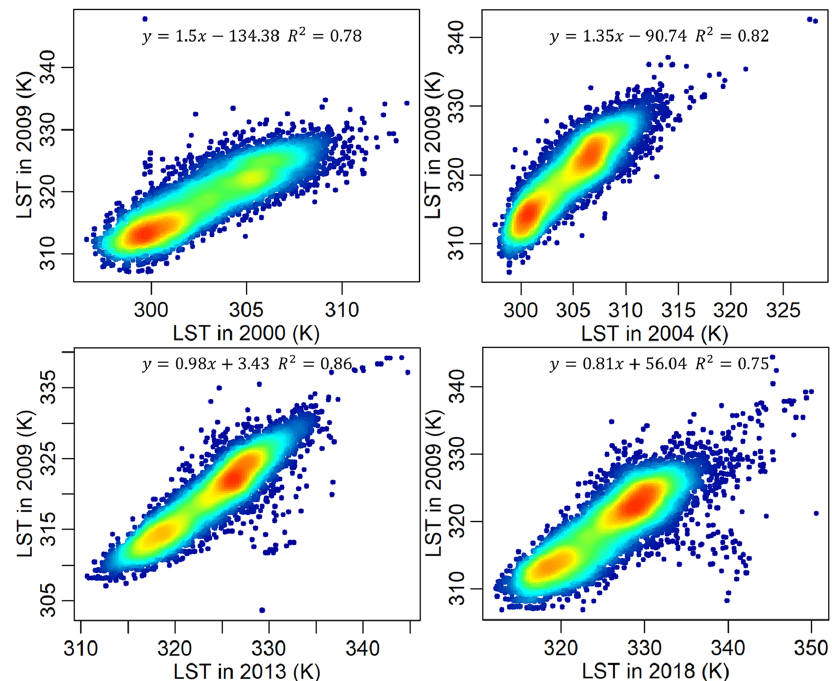
Figure 7. Scatterplot for LST of the PIFs between the target image (X-axis) and the reference image (Y-axis), the color indicates the density of points, red indicates the high density and blue indicates low density.